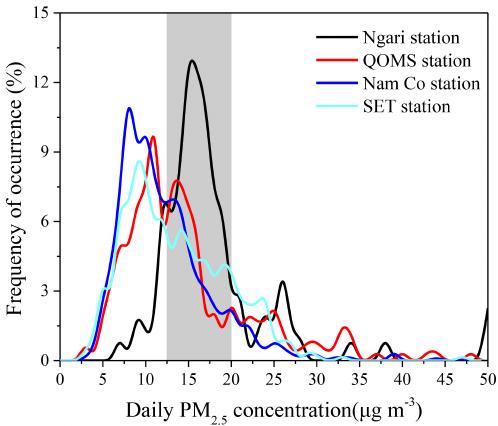
Figure 4. Frequency distributions of daily PM 2 . 5 concentrations over the HTP observed during the 2011–2013 period. High- concentration peaks around the range of 12.5–20µgm − 3 occurred in the frequency curves of the Ngari and QOMS stations, as indi- cated by the grey shading. The maximum PM 2 . 5 bin concentration was set to 50µgm − 3 , although a small fraction existed at higher